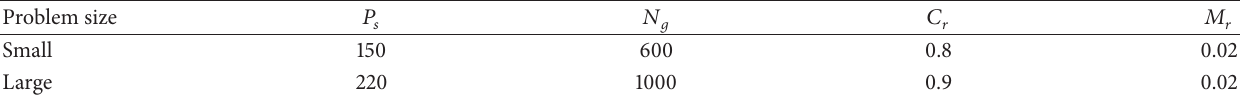
Table 8: Tuned values of the genetic algorithm